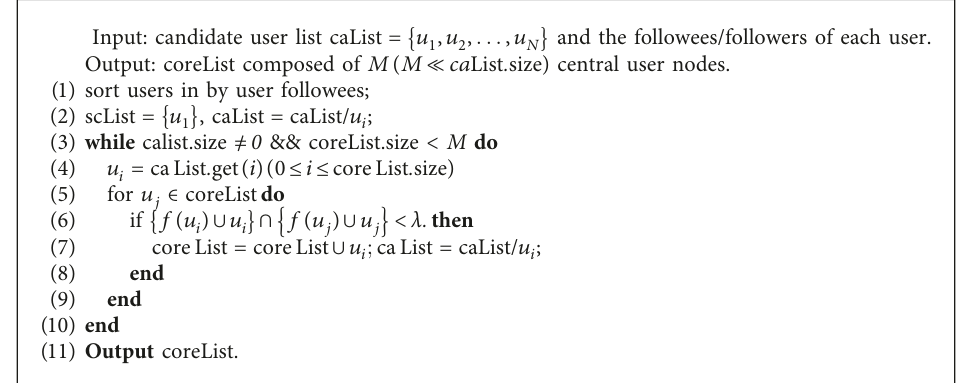
Input: candidate user list caList � u